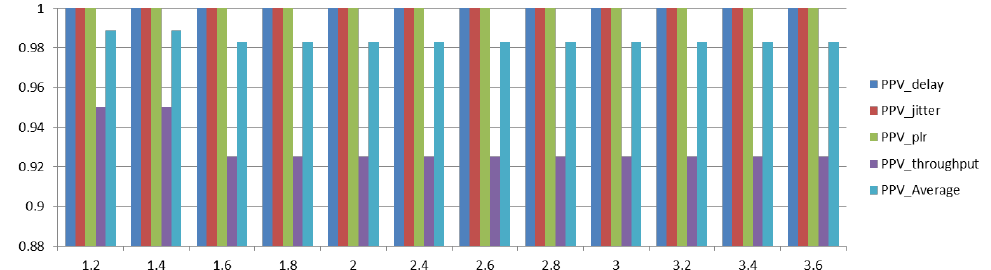
Figure 12. The Positive Predicted Value (PPV) of ReTRiEVED using the SIFT descriptor under different UBCMATCH thresholds.